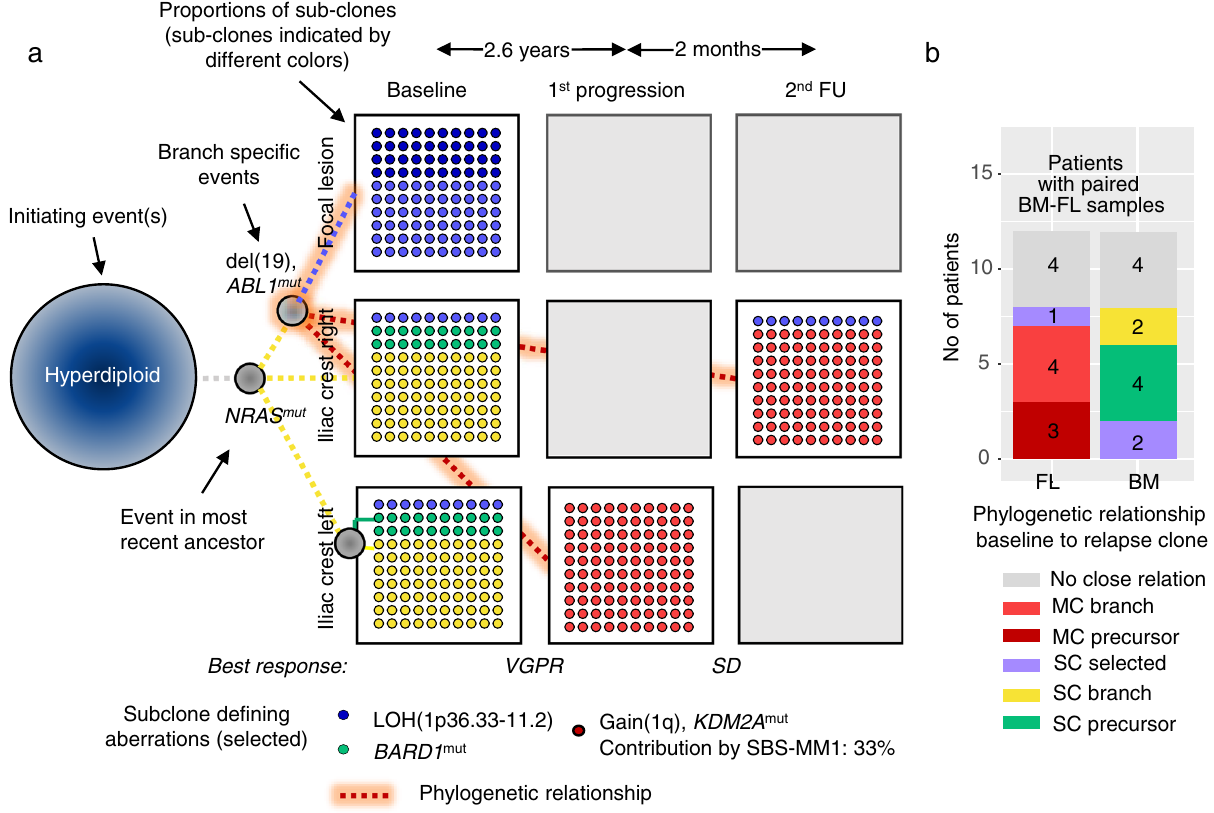
Fig. 3 | Phylogenetic relationship between baseline and relapse clones. We analyzed the phylogenetic relationship between baseline clones from different bonemarrowregionsandrelapseclonestoelucidatetheoriginofresistantdisease. To highlight the unknowns in our sample/dataset, we have chosen a format with fl ipped and un fl ipped (blank) cards reminiscent of a memory game. In a the